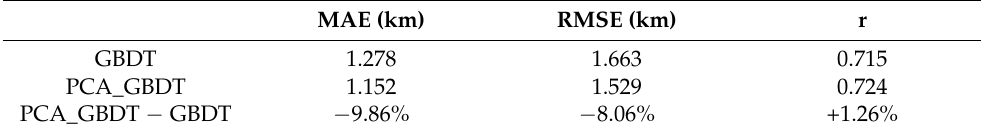
Table 9. Comparison of prediction accuracy between GBDT and PCA_GBDT